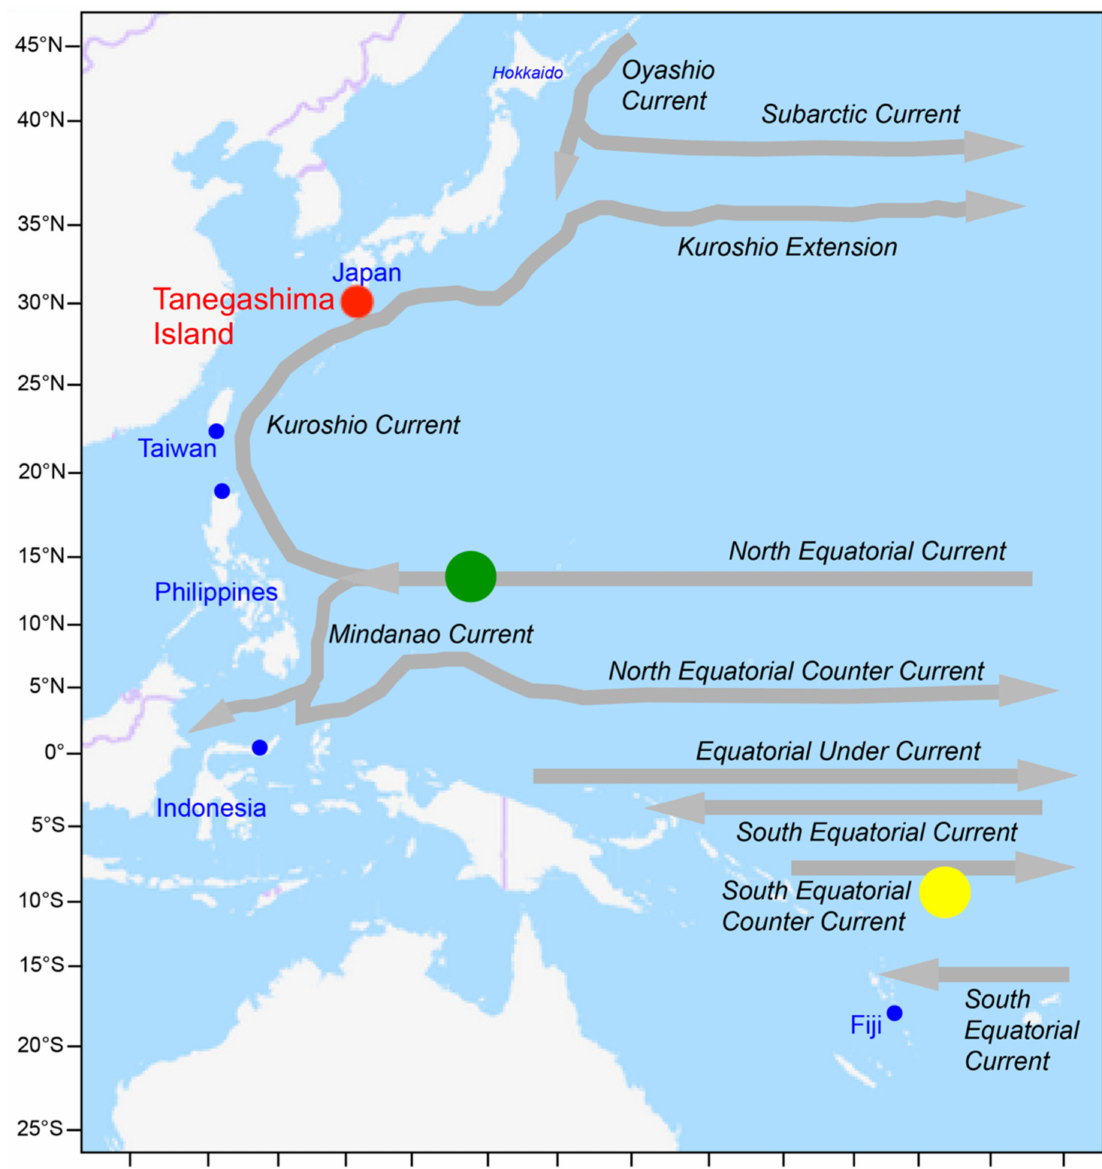
Figure 1. Map showing the Tanegashima Island (red circle) and other sites examined early life history in the previous studies (blue circle), surface currents and a spawning site (green circle) [47–50] in the North Equatorial Current and an estimated spawning site (yellow circle) [51] in the South Equatorial Current of Anguilla marmorata in the Pacific Ocean. The base map was downloaded from the OpenStreetMap (open access) at https://www.openstreetmap.org (accessed on 10 August